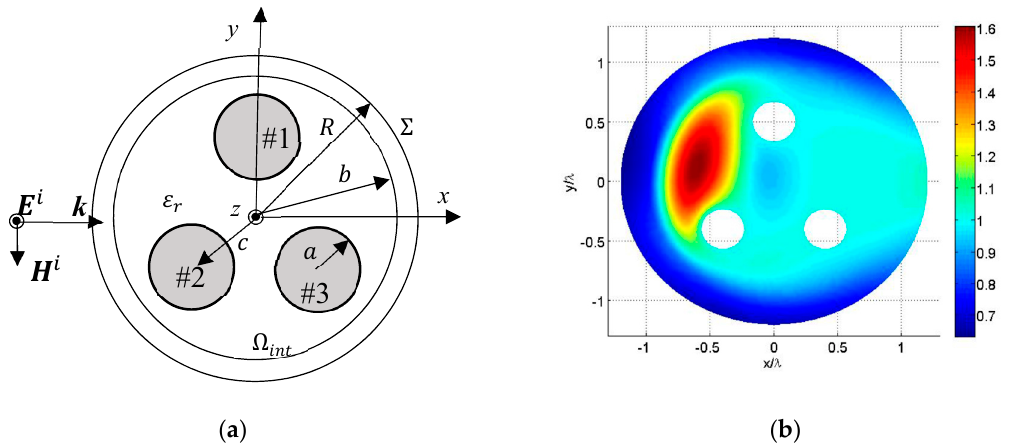
Figure 4. Case study 2 (cable bundle in air). ( a ) Geometry and references for evaluating the scattering from the cable, illuminated by a TM z plane wave; ( b ) Map of the amplitude of the scattered field, normalized to that of the incident field. The axes x and y are normalized to the wavelength value.